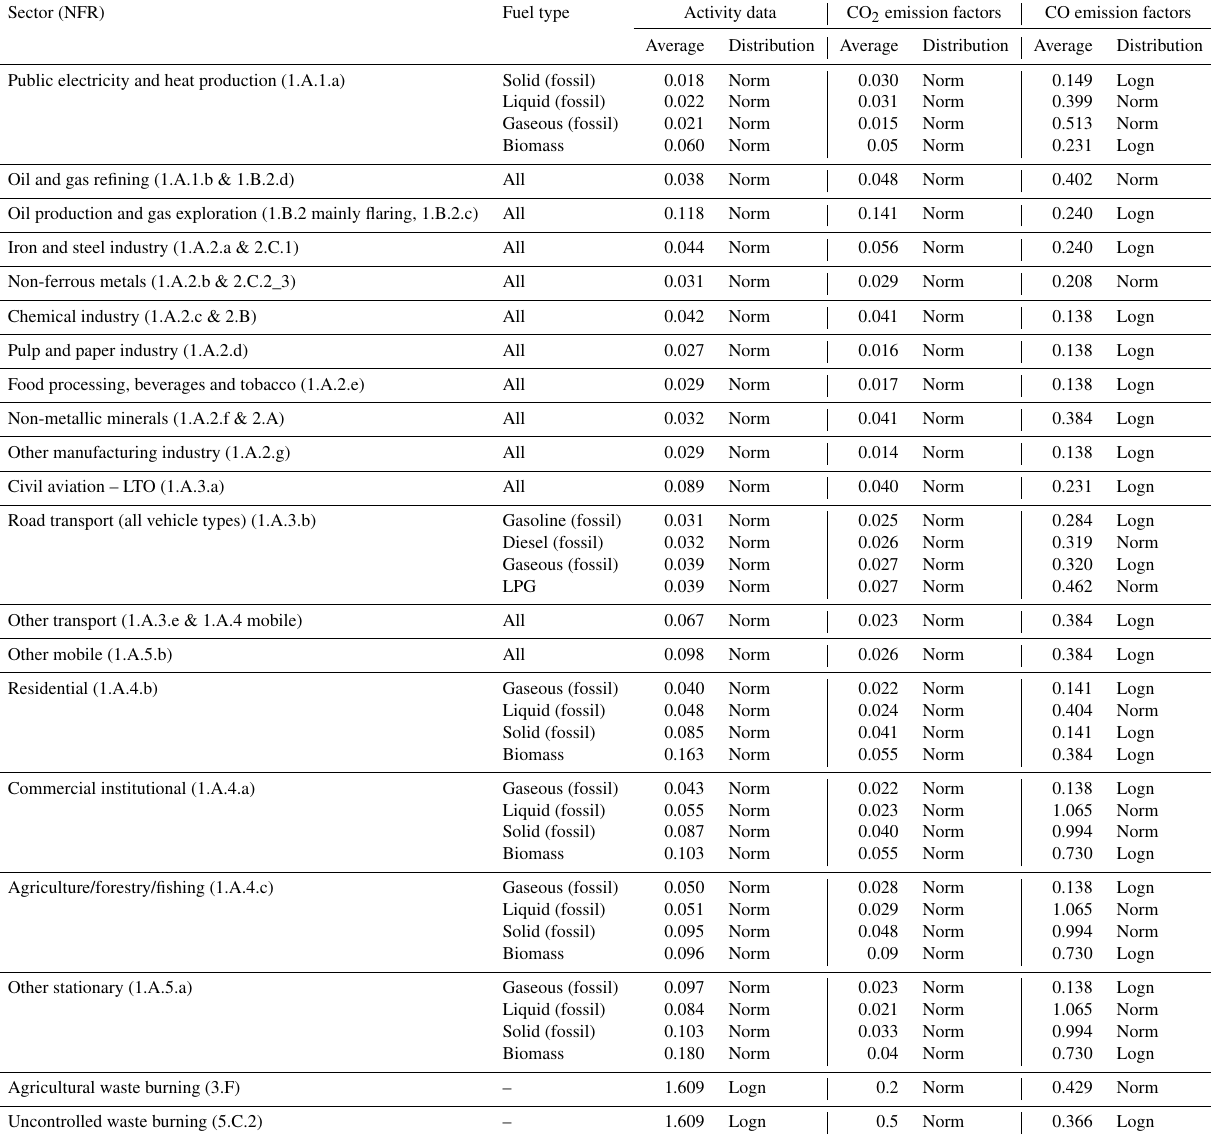
Table A1. Relative uncertainties (fraction) in activity data and CO 2 emission factors as taken from the NIRs (country average) and in CO emission factors as derived from literature (assumed equal for all countries in the domain). The quoted uncertainty ranges are assumed to be representative of 1 standard deviation. Uncertainties in activity data and CO 2 emission factors are often relatively low and symmetrically distributed, and normal distributions (Norm) are assumed for these activities. Compared to CO 2 emission factors, the uncertainty in CO emission factors is much higher, up to an order of magnitude. Uncertainties in CO emission factors are often lognormally distributed (Logn) and are assumed equal for all countries in the HR domain. The uncertainty in the activity of open burning of waste (not covered by the NIRs) is also assumed to have a lognormal